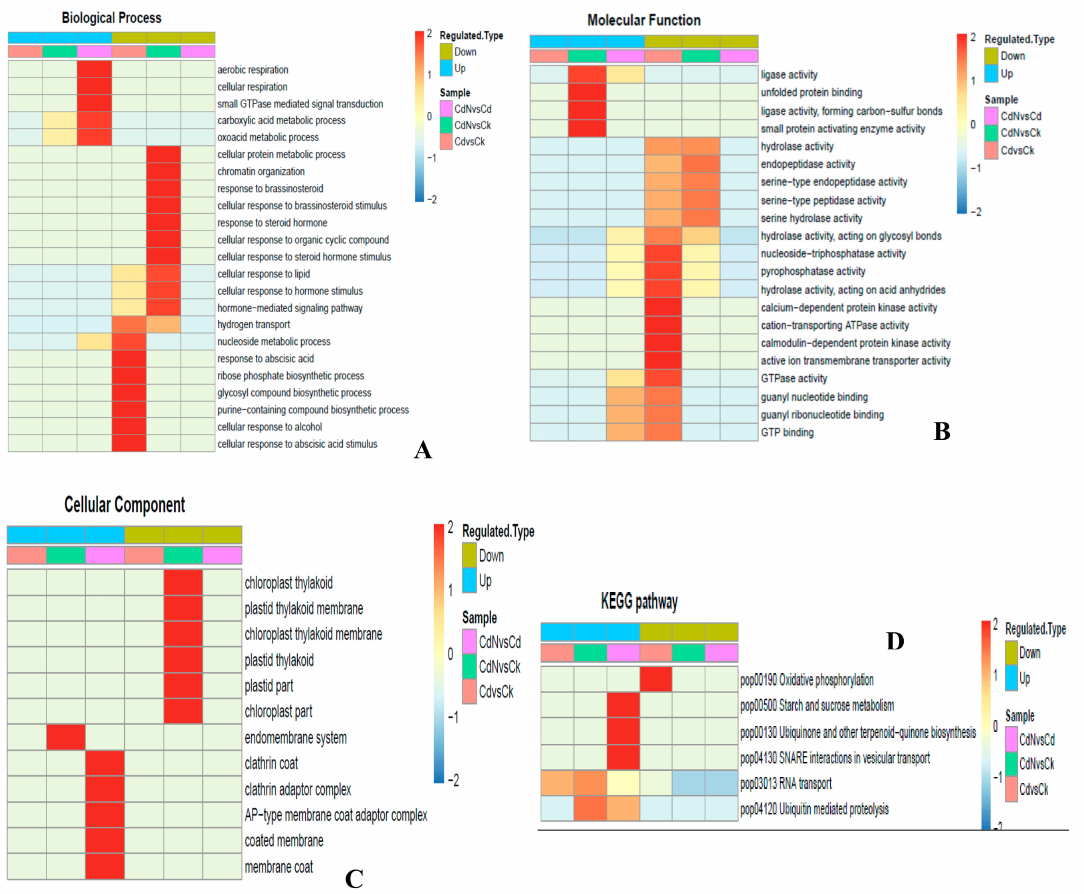
Figure 4. Gene ontology (GO) enrichment-based clustering analysis of the quantified phosphoproteome based on Zscore (–log10 ( p -value); from –2 to 2). ( A ) biological process category. ( B ) The molecular function category. ( C ) The cell component category. ( D ) KEGG pathway